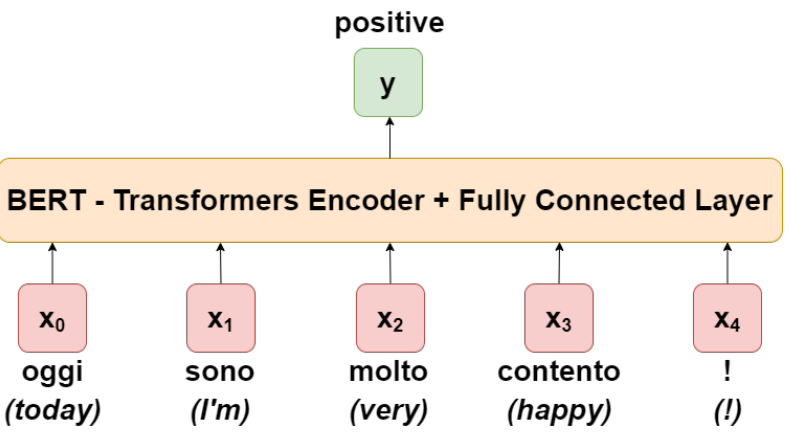
Figure 2. BERT architecture overview. Table 3. Hyper-parameters of the fine-tuned Italian BERT XXL